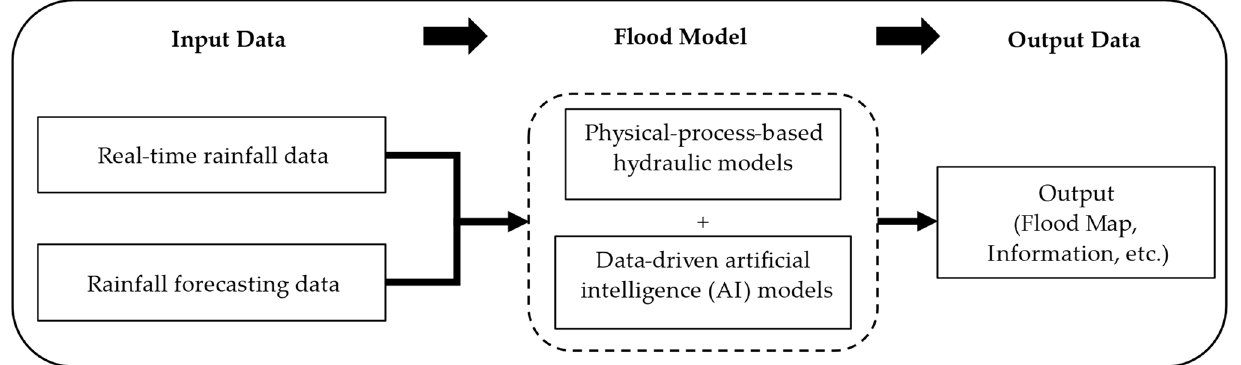
Figure 3. Conceptual diagram of the blended approach of a physical-process-based hydraulic model with a data-driven AI model for real-time urban flood forecasting systems .